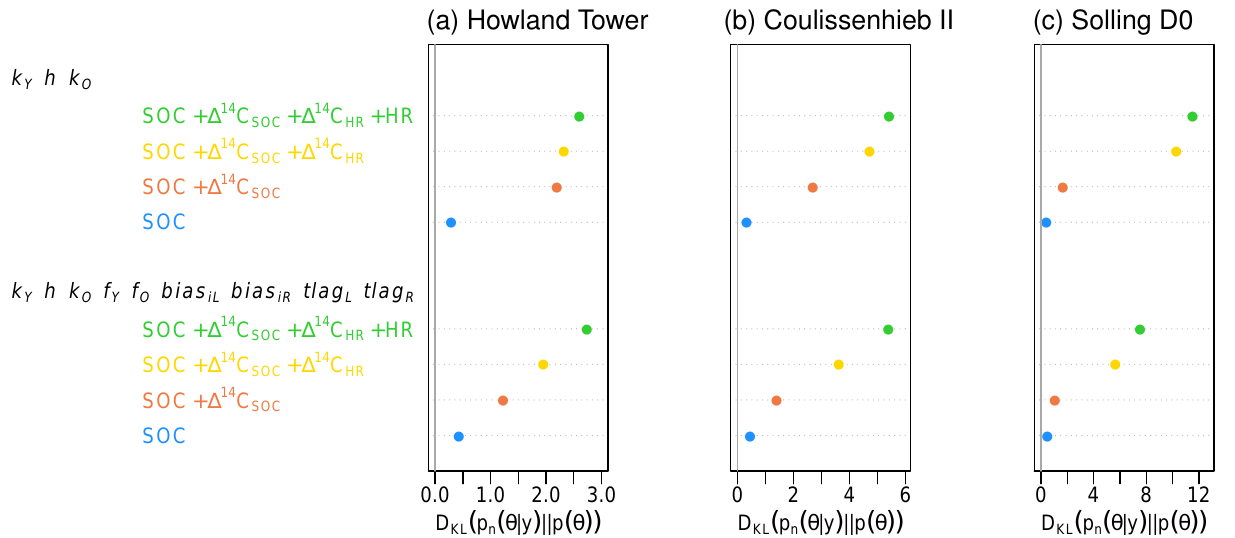
Fig. 6. Kullback–Leibler divergence, D KL , at all three sites between the joint posterior distributions p(θ | y) of the n calibration experiments and the joint prior distributions p(θ) of the parameters k Y , h and k O , and of all calibrated parameters.